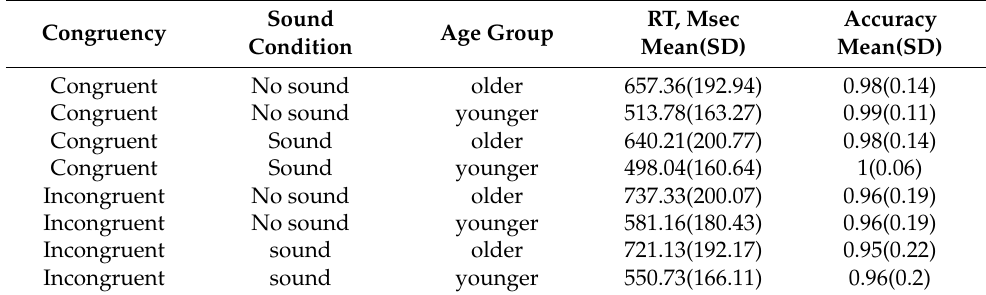
Table 2. Model estimated RT and accuracy in the modified Simon